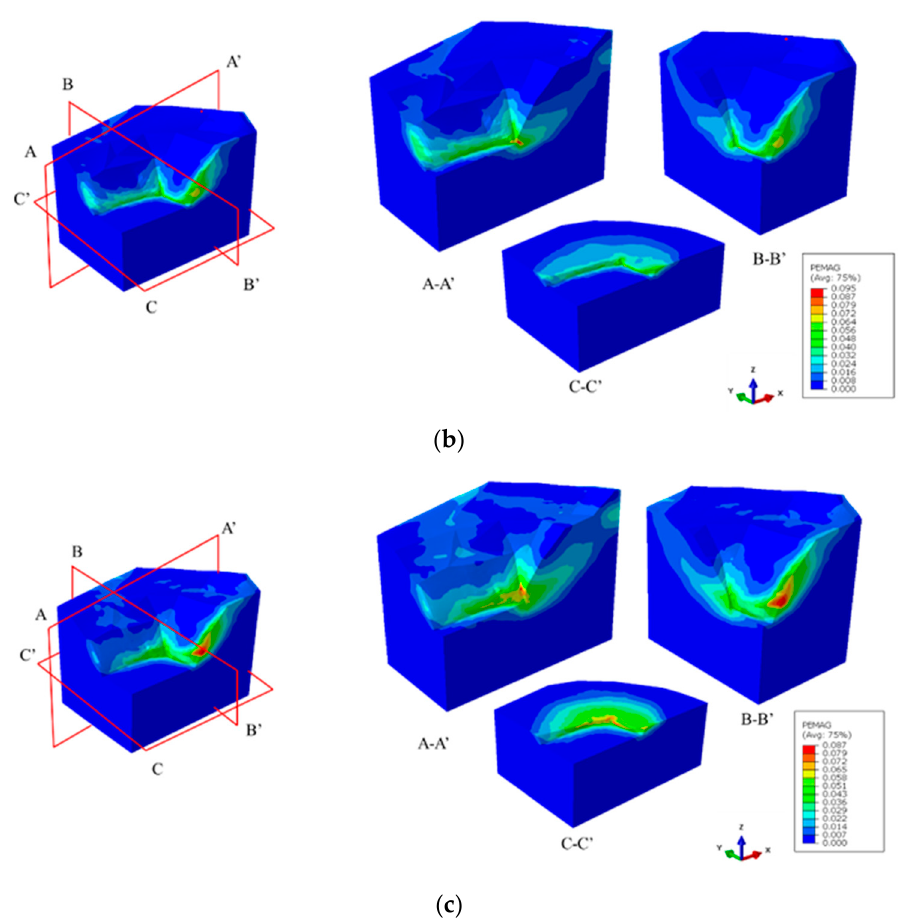
Figure 15. Plastic strain diagram of the slope with 30° rotation angle of the weak zones. ( a ) Rotation angle of 30° around the X -axis ( FOS = 1.87); ( b ) rotation angle of 30° around the Y -axis ( FOS = 1.89); ( c ) rotation angle of 30° around the Z -axis ( FOS = 1.94).